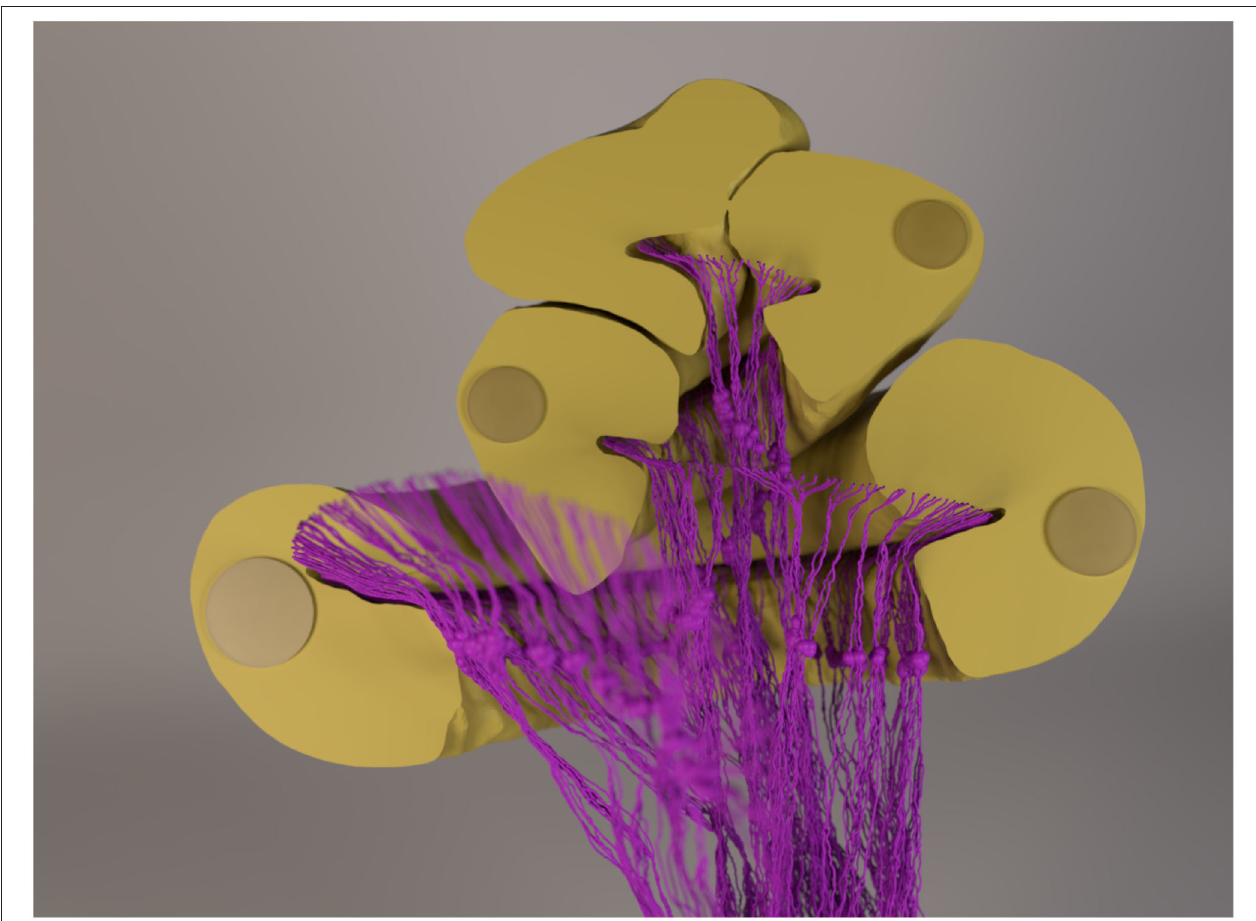
FIGURE 2 | A rendered image of the 3D cochlea model and the neurons with 1.5-mm-long dendrites. The cochlear canal, as well as the implanted electrode, was cut to provide a better view of the neurons. The “out-of-focus” neurons in the image sit in front of the cut-plane. Note that the diameter of the fibers (and the somata) is amplified for visualization purposes, i.e., they are not to